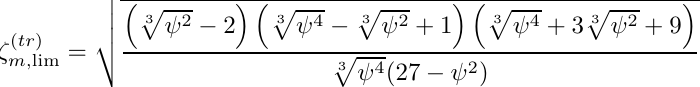
Fig. 20. Behaviour of TRF modulus of the complex damped SDOF